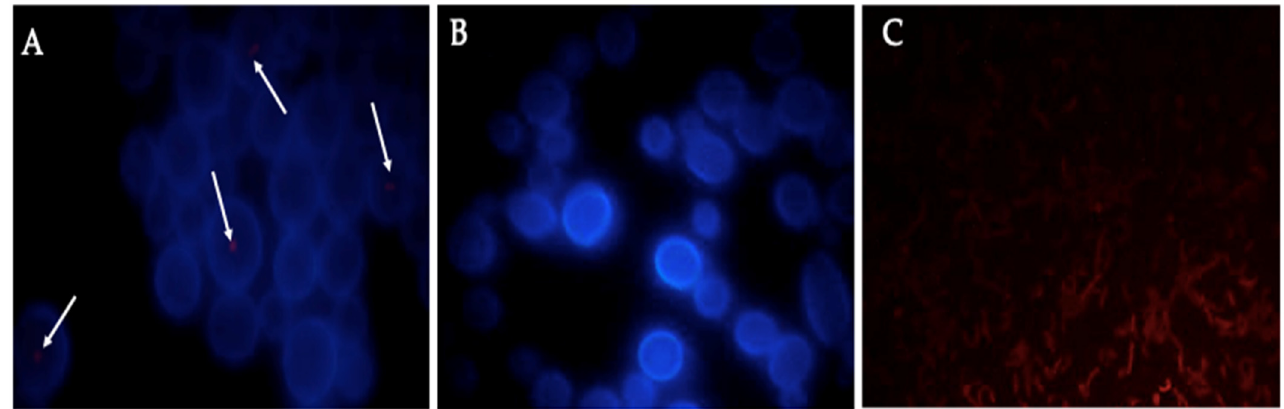
Figure 9. Images showing the results of FISH analysis using a fluorescent probe specific for H. pylori . Yeast cells obtained from a H. pylori G-27– C. glabrata ATCC 90030 strain co-cultured in BB-5%FBS. ( A ) Hybridization of the H. pylori specific probe within C. glabrata ATCC 90030 cells (white arrows); ( B ) C. glabrata ATCC 90030 from a pure culture (negative control) showing the absence of hybridization of the fluorescent probe; ( C ) Pure H. pylori G27 strain used as positive control (red fluorescence). Blue fluorescence corresponds to the binding of aniline blue to 1–3 ℬ -glucans of yeast cells. BB-5%FBS: Brucella broth supplemented with 5% FBS.